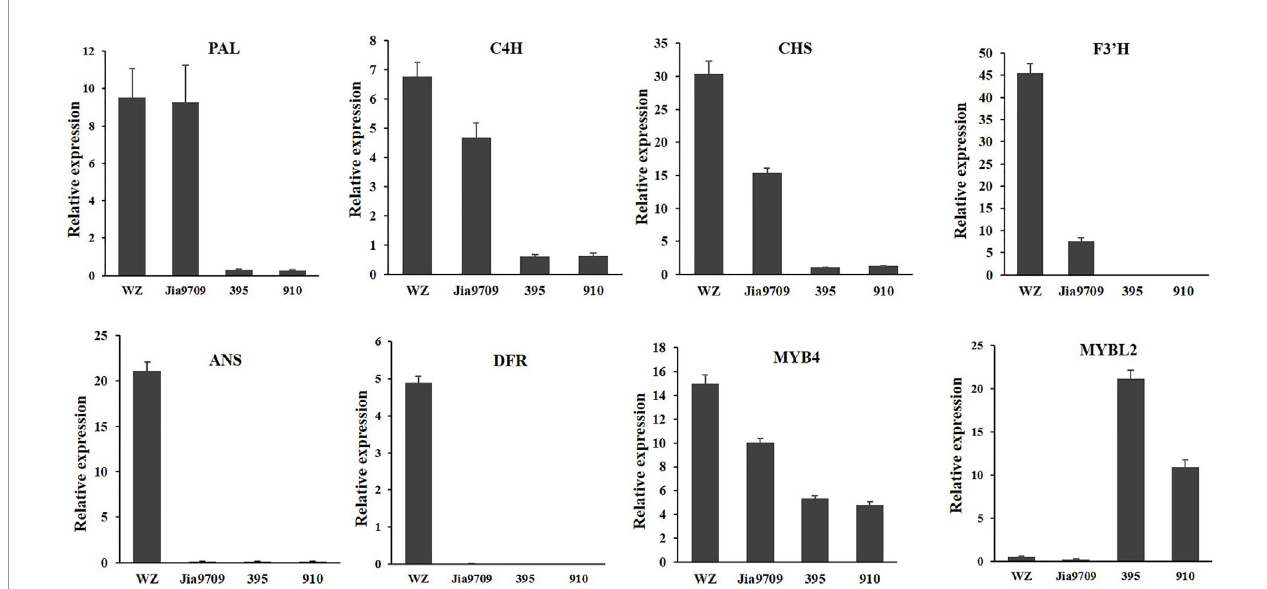
FIGURE 9 | qRT-PCR analysis of eight anthocyanin biosynthesis genes in J9709, transgenic plants with full-length BnaPAP2. A7 (wz), 395 and 910